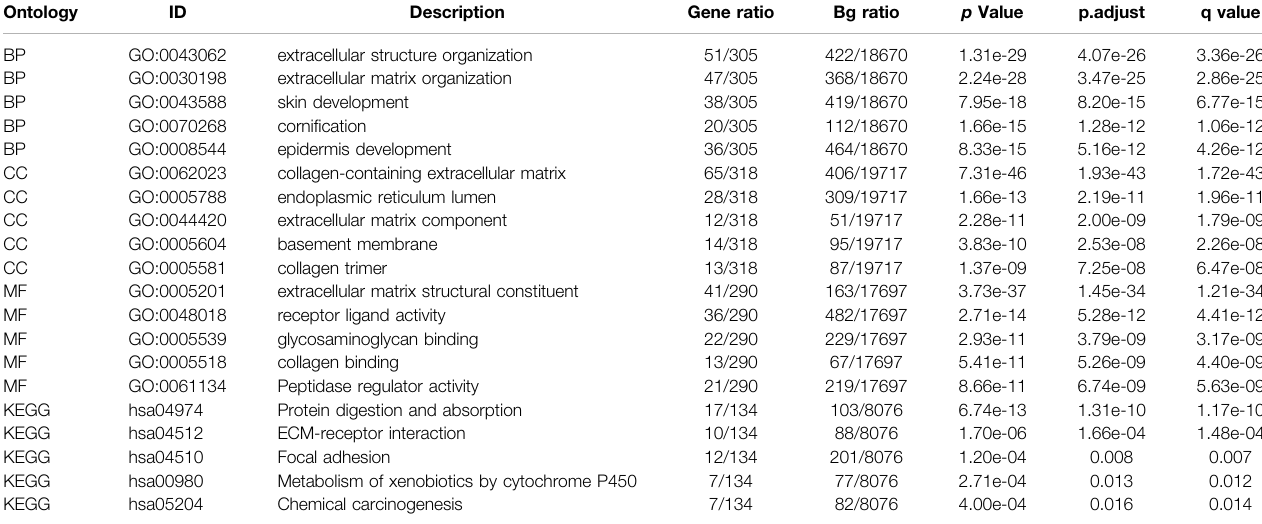
TABLE 3 | GO and KEGG enrichment analysis.